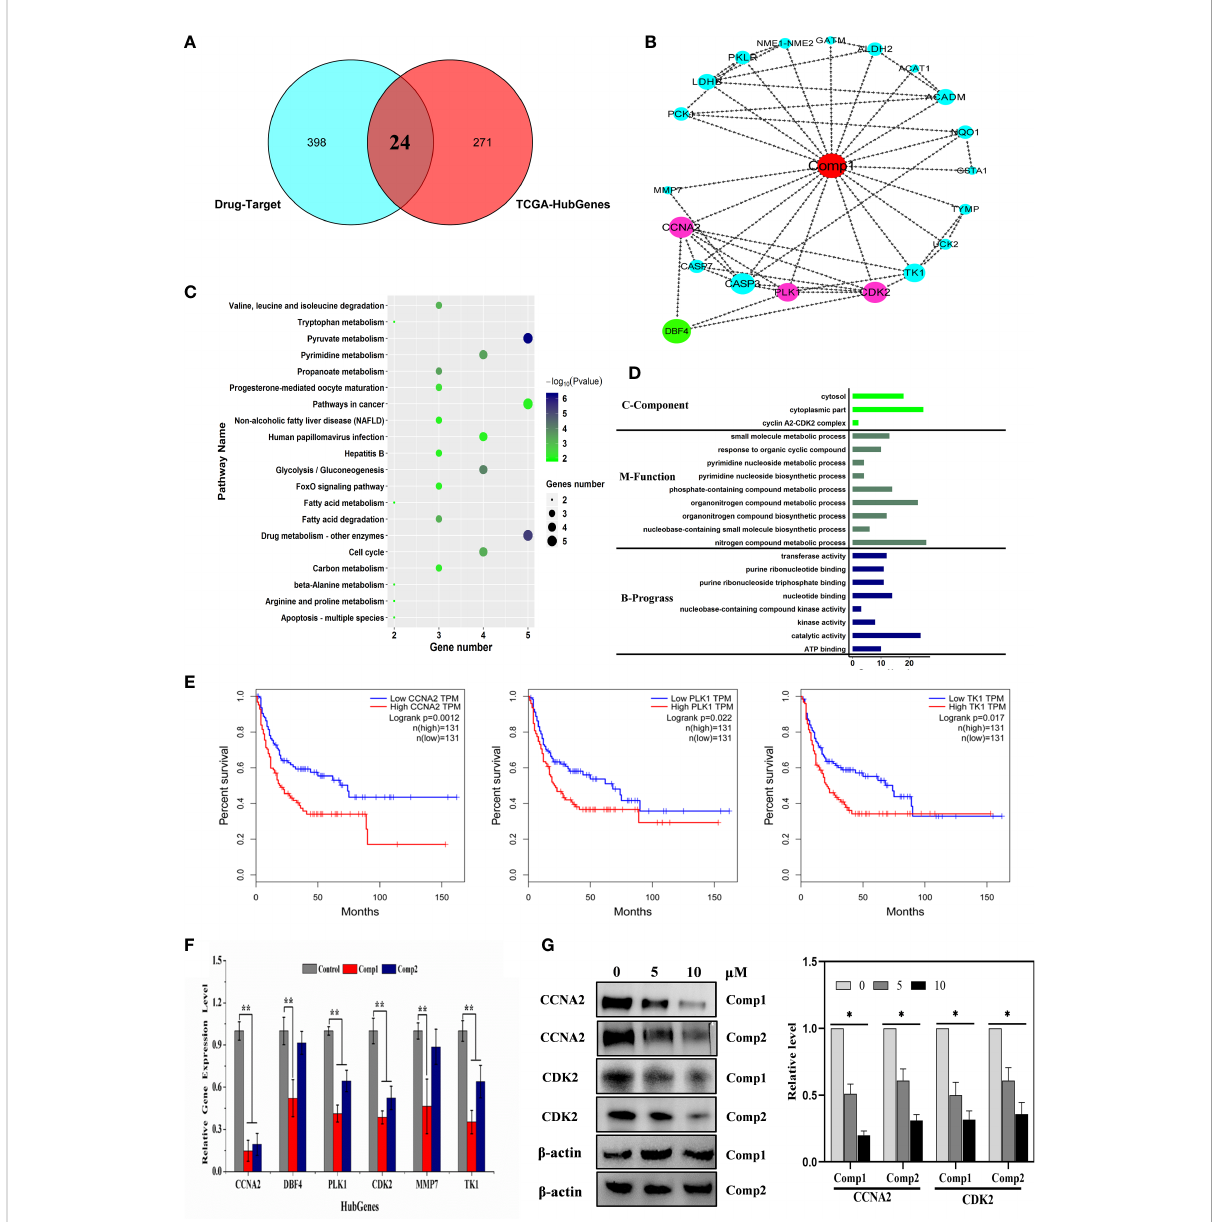
FIGURE 6 Cell cycle-related factors associated with cancer were affected by carboline. (A) The Venn diagram displays the common genes shared by the SARC and predicted drug-target pro fi les. (B) PPI network analysis of 19 hub genes. The network was constructed using the CytoHubba plugin in Cytoscape, and the core gene scores were calculated using the maximal clique centrality (MCC) method. The deeper the color of the node is, the higher the PPI score of the targets, and the red nodes represent the b - carboline-3-carboxylic acid dimers. (C) KEGG pathway analysis of 24 targets from Venn analysis. (D) Differential and functional enrichment analysis of 24 targets shared by SARC-related transcriptomic pro fi les and drug-target networks. (E) Disease-free survival analysis for predicted target genes and TCGA consensus genes, P <0.05 ( CCNA2 , PLK1 , and TK1 ). (F) mRNA expression of CCNA2 , DBF4 , TK1 , PLK1 , MMP7 , and CDK2 in MG-63 cells detected by RT – qPCR. (G) Western blot analysis of CCNA2 and CDK2. MG-63 cells were treated with Comp1 and Comp2 at 5 and 10 µM for 48 h. ACTB was used as an internal control. *P < 0.05, **P <